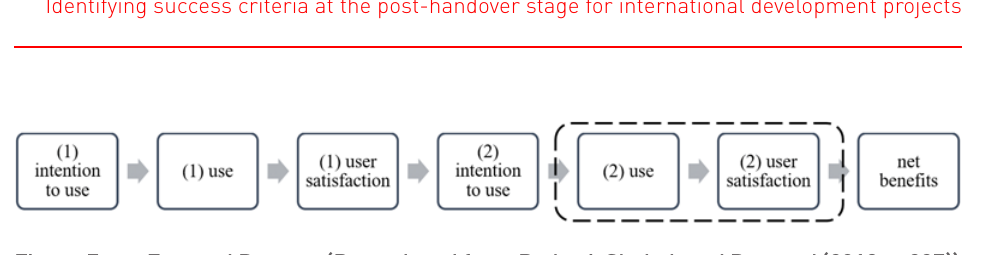
Focused Process (Reproduced from Badewi, Shehab and Peppard (2013,